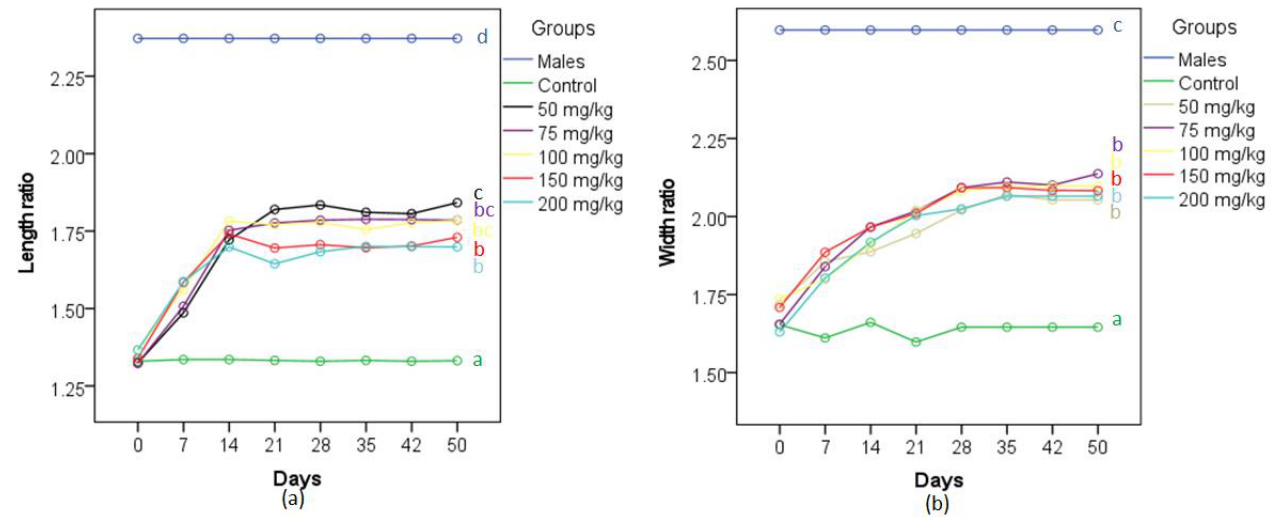
Figure 4. Temporal changes in ( a ) the ratios of the lengths of anal fin rays 4 and 6 and ( b ) the ratios of the widths of anal fin 3 and 4 of MG females treated with different concentrations of MT in their diet ( n = 11). Lines with different letters (color coded to match those of the lines) are significantly different from one another.